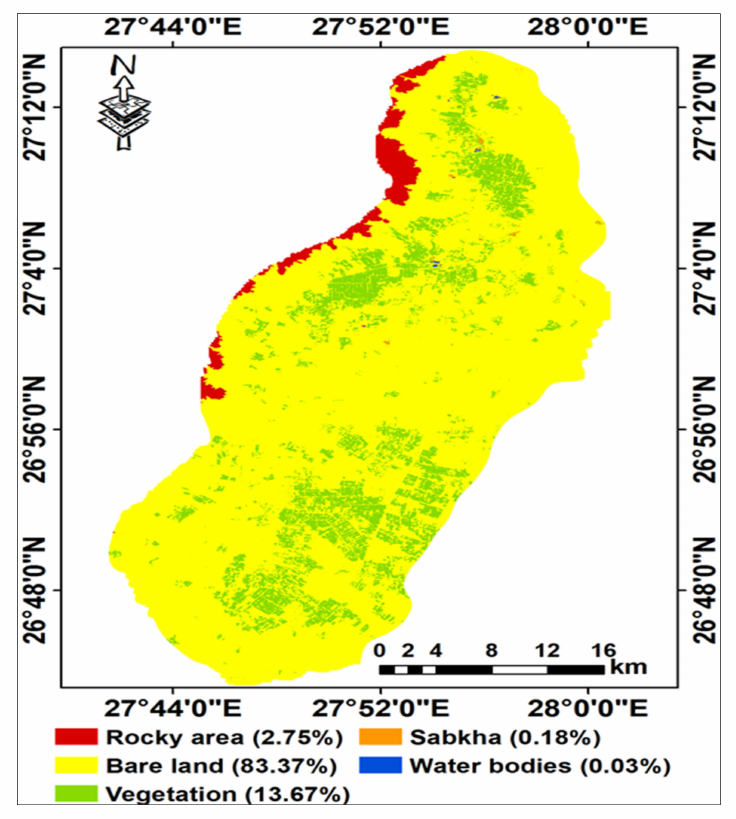
Figure 4. Land cover map of the studied area. Table 2. Physiographic map legend and soil taxonomy of the studied